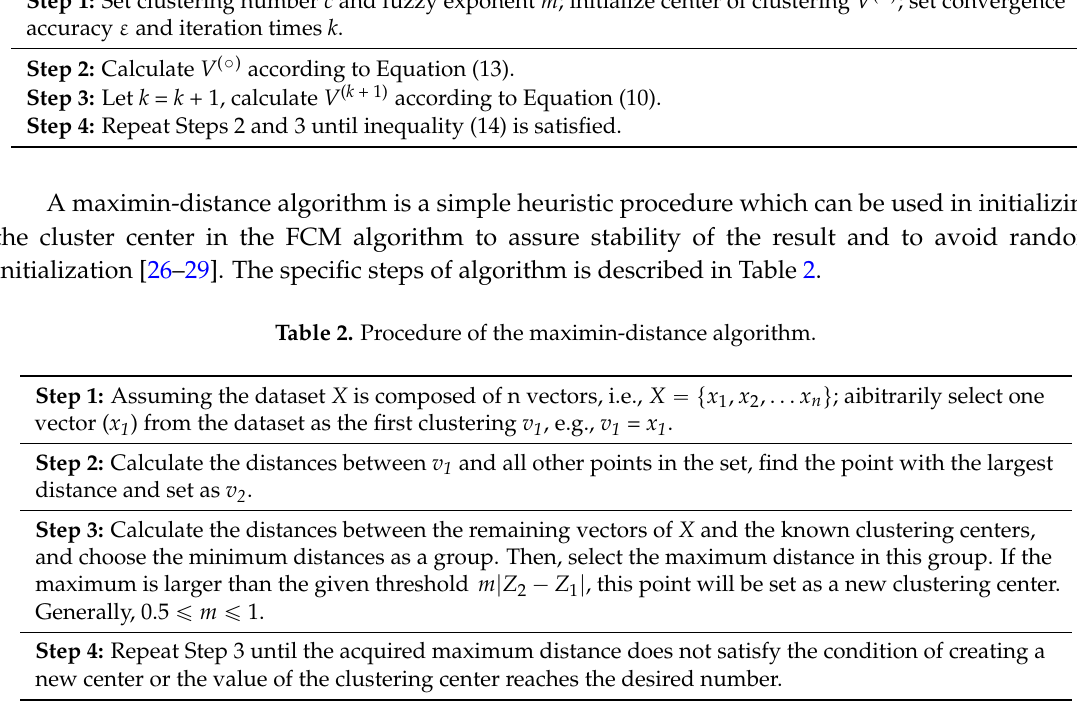
Table 1. Specific steps of the FCM clustering algorithm.